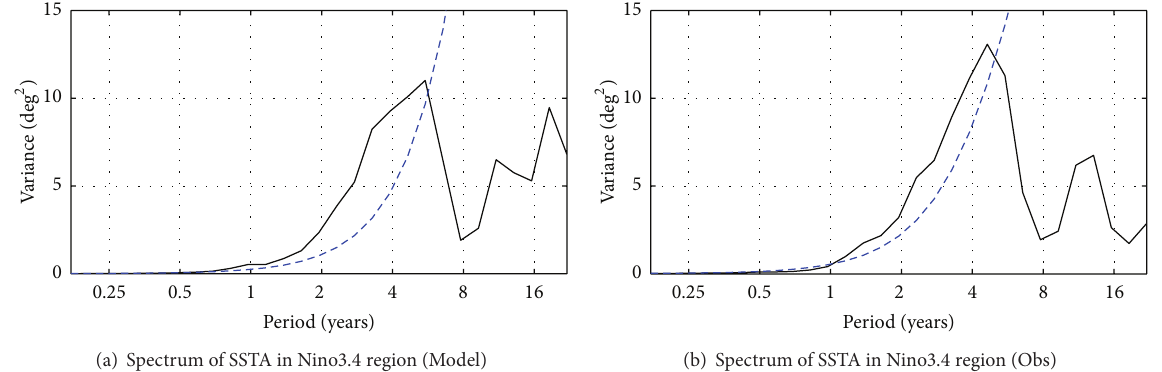
Figure 3: The power spectrum of the SST anomalies in the Nino3 region during 1950–2006 obtained from the (a) model simulation and (b)